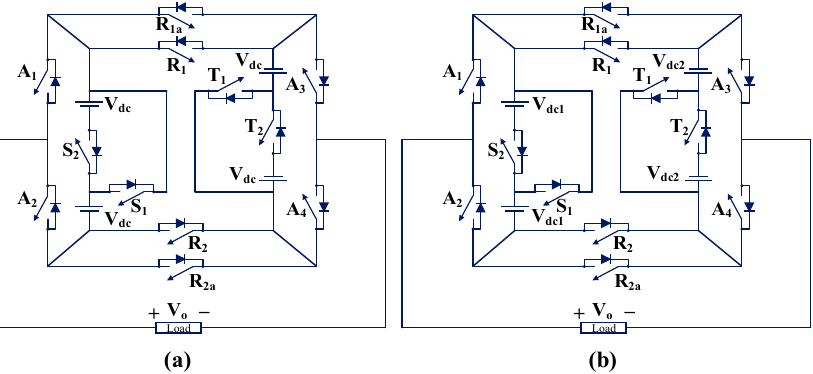
Figure 15. Single-phase symmetric FT MLI: ( a ) nine-level symmetric configuration (TP15) and ( b ) seventeen-level asymmetric configuration (TP16) [53].